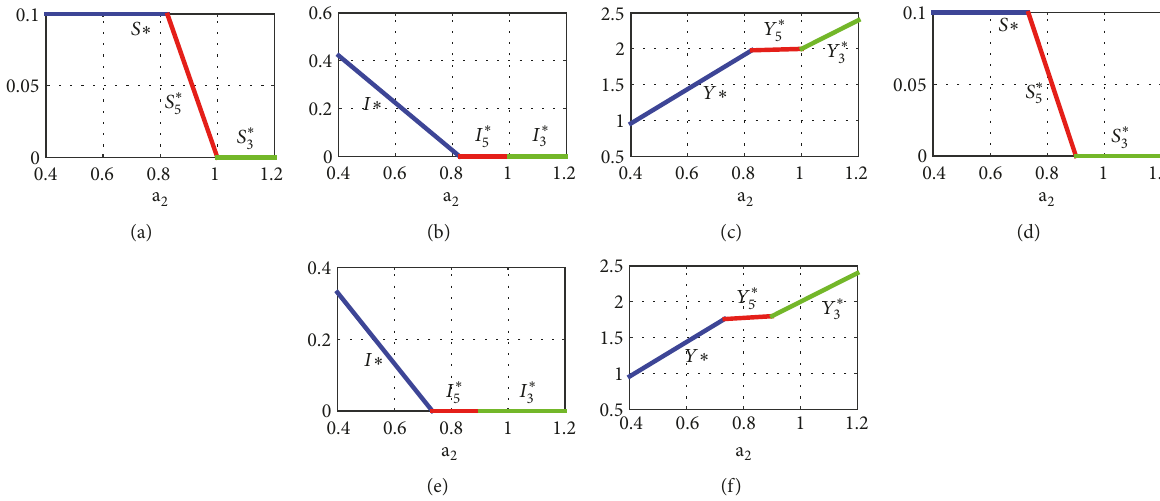
Figure 2: The stable equilibrium point as function of 𝑎 2 for ((a)-(c)) 𝛼 = 0 and ((d)-(f)) 𝛼 = 0.1 . The parameter values are 𝑟 = 1,𝐾 = 1,𝛽 = 0.1, 𝑐 = 0.01, 𝑐 = 0.5, 𝑐 = 0.25, 𝑘 = 1 , and 𝑘 = 0.5 1 2 1 2